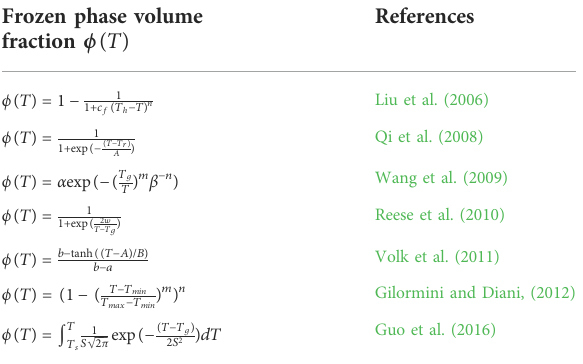
TABLE 1 Frozen phase volume fraction functions proposed in existing literature studies. Frozen phase volume fraction ϕ ( T